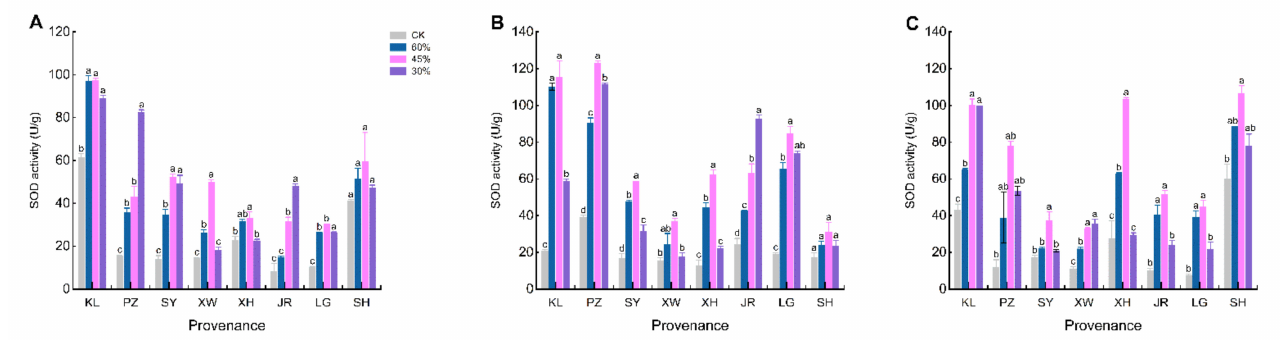
Figure A5. The superoxide dismutase activity of Melia azedarach among the different provenances: ( A ): early stage, ( B ): middle stage, and ( C ): late stage. Note: The error line in the figure is the mean ± standard error, and different lowercase letters in the same treatment indicate signifi- cant differences at the 0.05